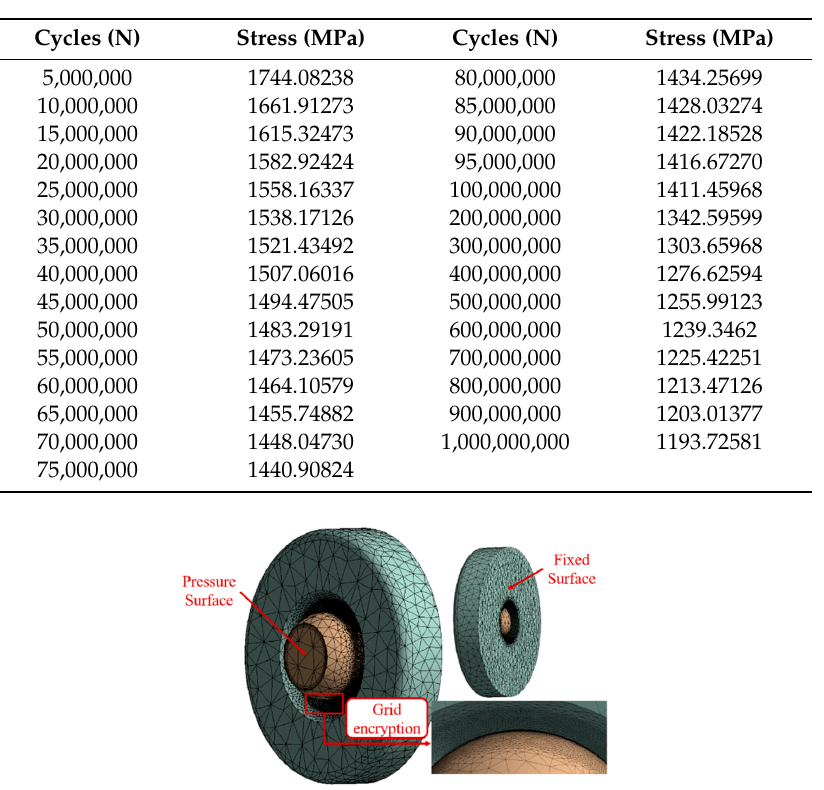
Table 3. The data sheet of fatigue life curve.